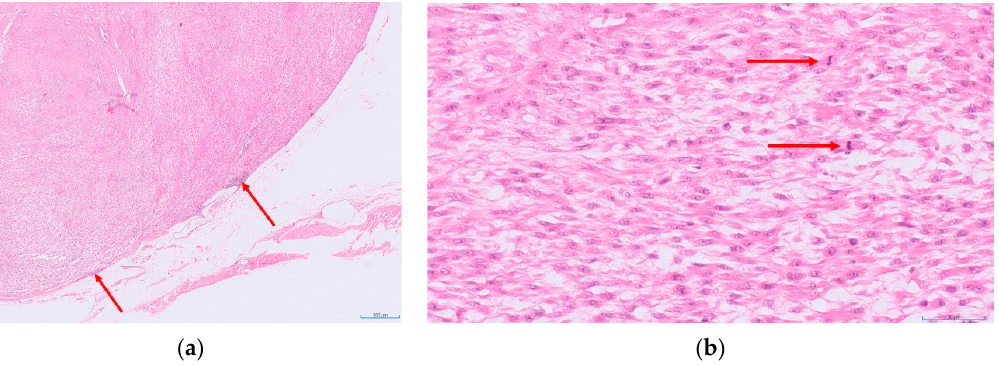
Figure 2. An example of a feline cutaneous soft tissue sarcoma of intermediate histological grade (grade II): ( a ) low power view of the tumour, with red arrows indicating very mild inflammation (score 1) with occasional focal lymphoid aggregates at the periphery only (HE-stained; 2 × magnification); ( b ) a higher power view of the same tumour showing mitotic activity (red arrows indicate mitotic figures), with a mitotic count of 26 in 10 HPFs (400 × ; 2.37 mm 2 ; score 3). This tumour contained some areas of necrosis but these comprised less than 50% of the total tumour present in the sections (score 1)—giving a total score of 5 (HE-stained; 400× magnification).